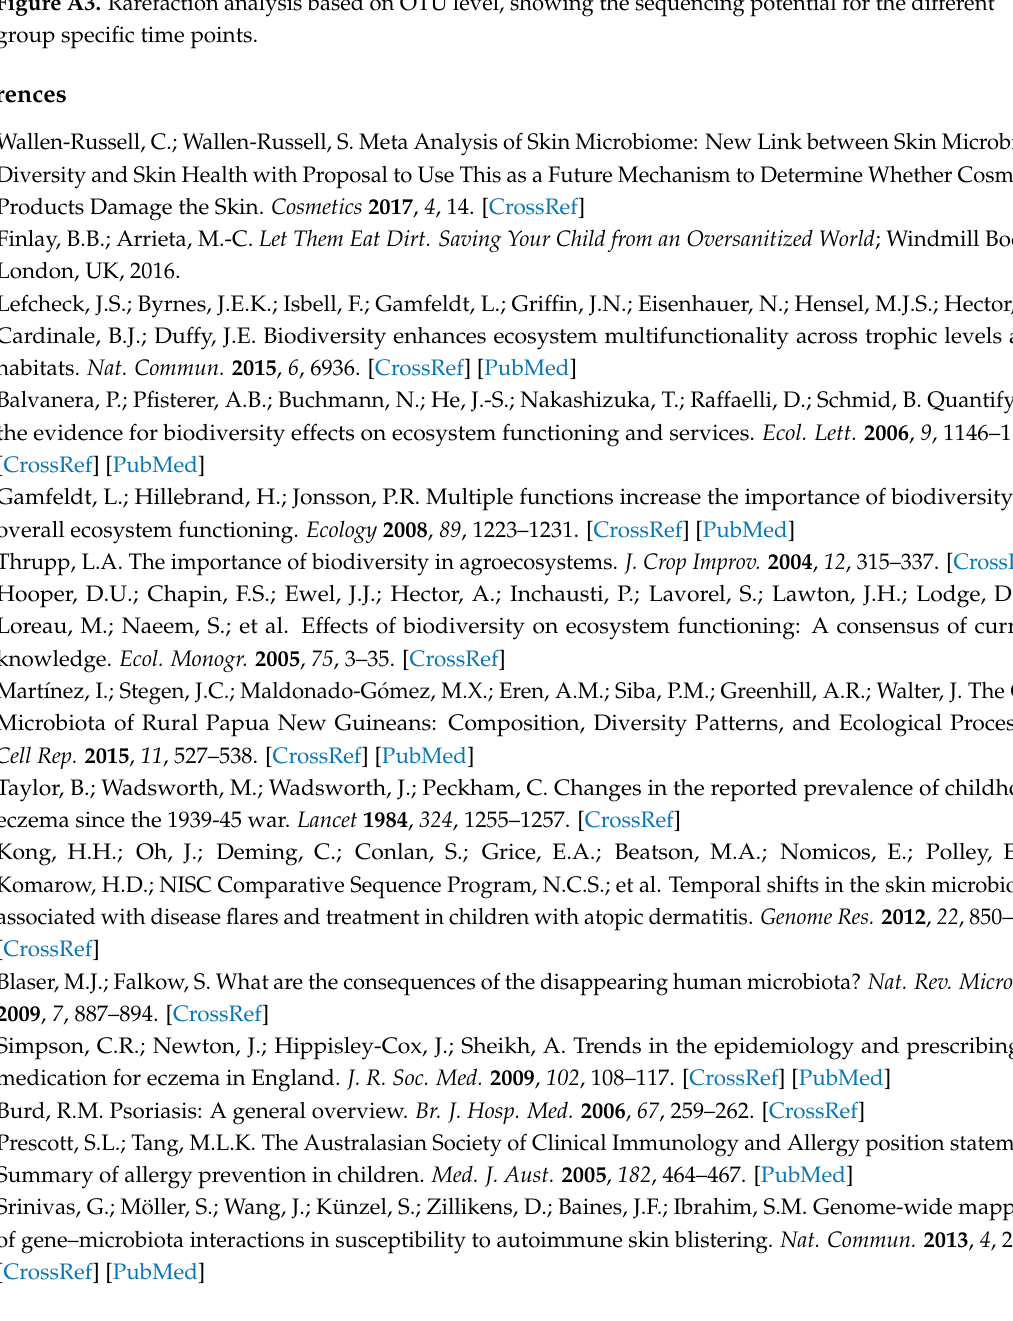
Figure A3. Rarefaction analysis based on OTU level, showing the sequencing potential for the different